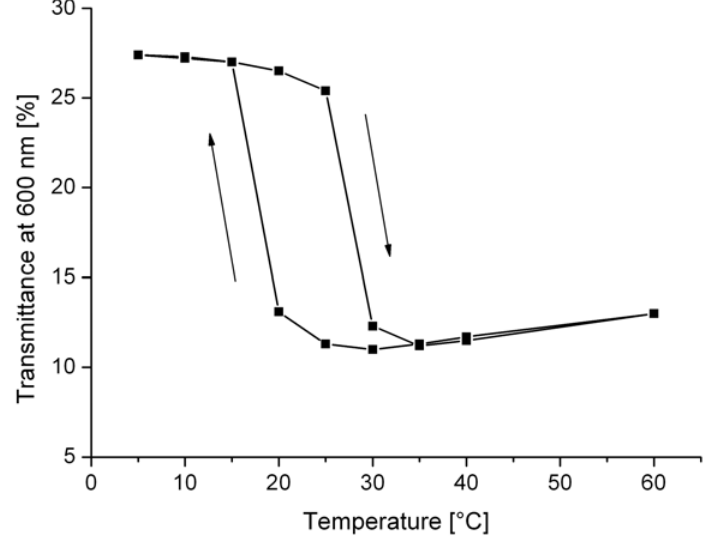
Figure 3. Normal-normal transmittance at 600 nm of the thermotropically modified PE film TF 35 depending on the temperature during heating and cooling